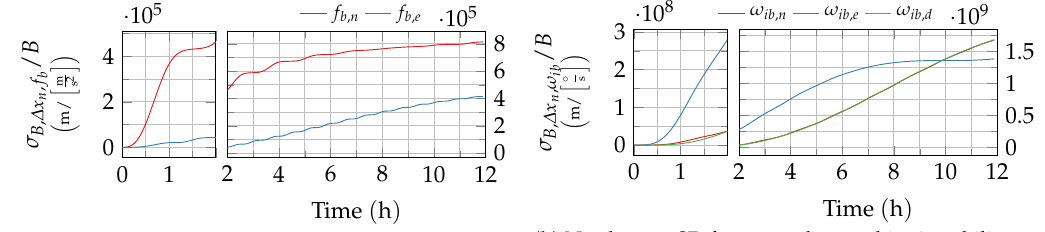
( a ) North error SD from acceleration bias instability. ( b ) North error SD from angular rate bias instability.